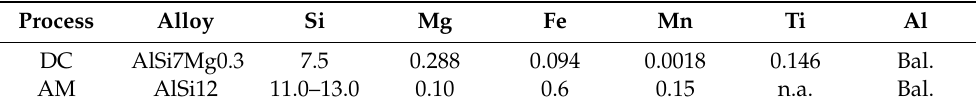
Table 1. Chemical composition of die-cast (DC) and additively manufactured (AM) alloy AlSi7Mg0.3 and AlSi12, all data in